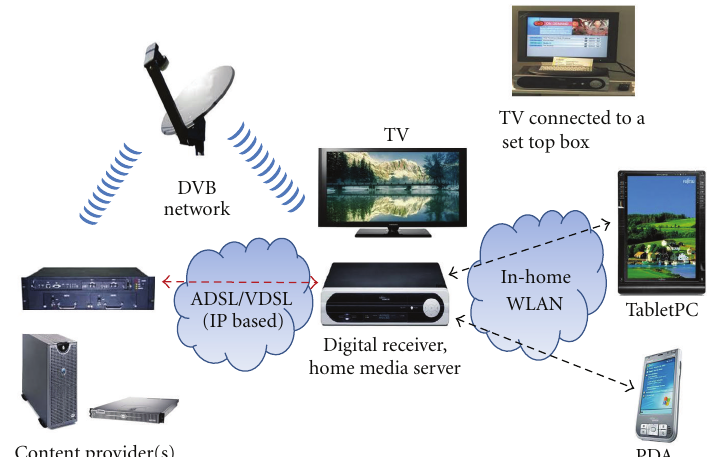
Figure 1: Scalable rich media TV service.